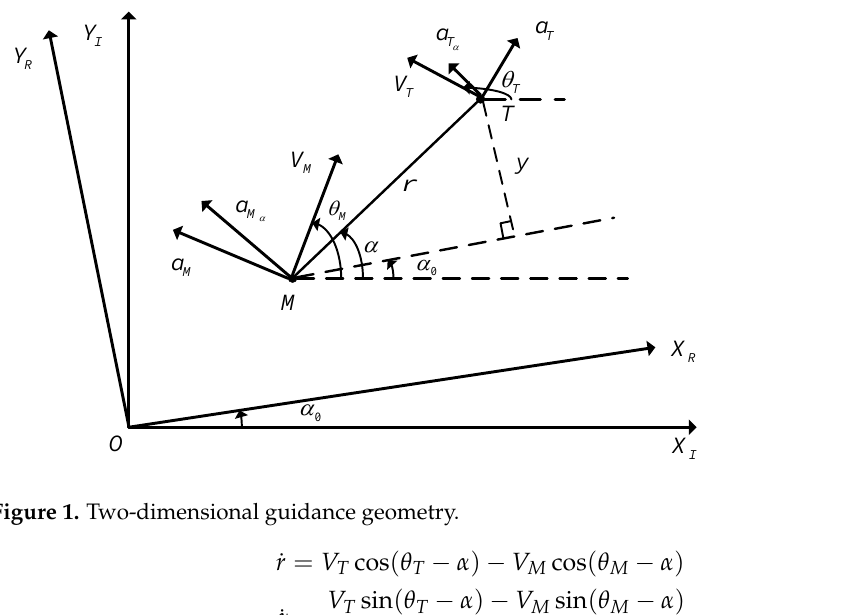
Figure 1. Two-dimensional guidance